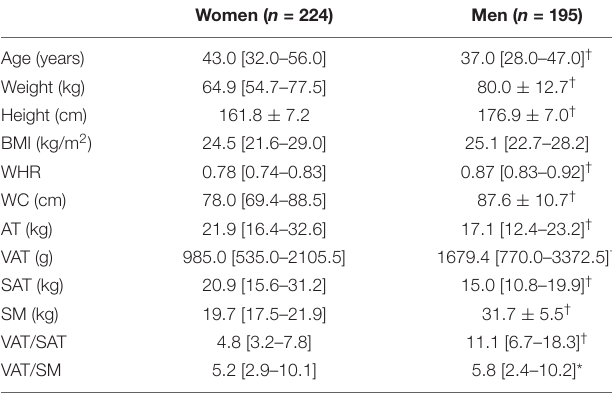
TABLE 1 | Characteristics of the